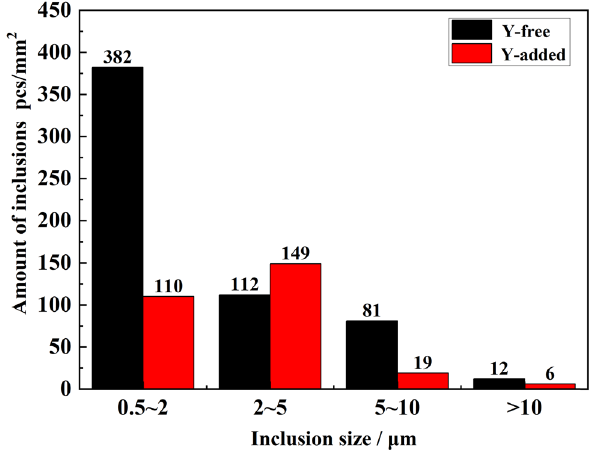
Figure 6: Statistical results of the number and size of inclusions in experimental